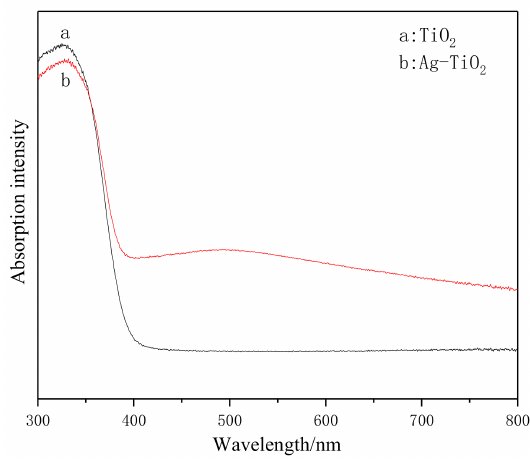
Figure 5. UV-Vis-Abs of pure TiO 2 and Ag-TiO